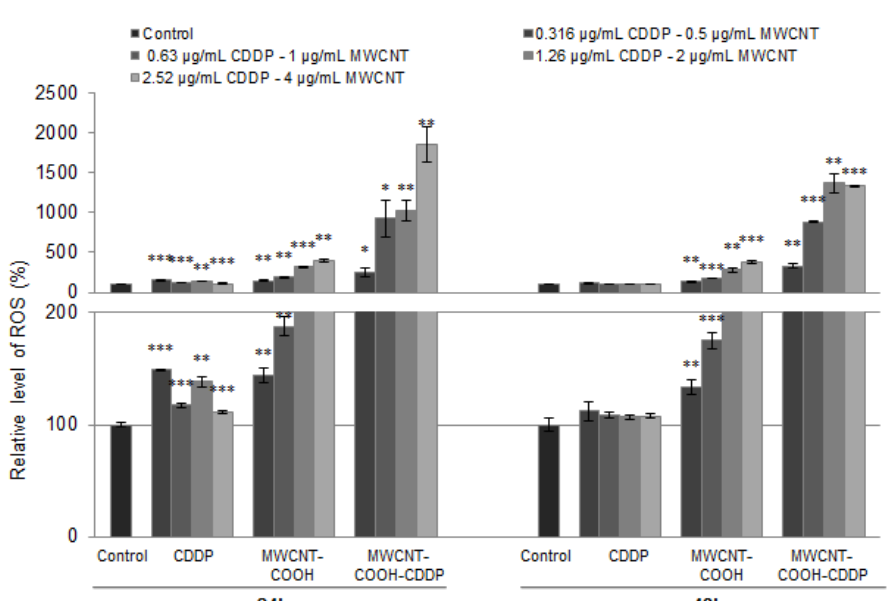
Figure 9. Relative level of ROS production after the exposure of MDA-MB-231 cells to MWCNTs (0.5–4 µg/mL) and CDDP (0.316–2.52 µg/mL) for 24 h and 48 h. The results are calculated as the mean ± SD of 3 replicates and represented relative to control. * p < 0.05, ** p < 0.01, *** p < 0.001 vs. control. The